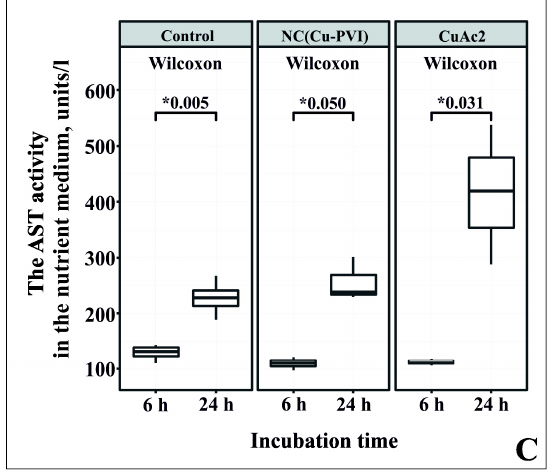
Figure 7. Change in AST activity in the culture medium after 6 h ( A ) and 24 h ( B ) of incubation with NC(Cu-PVI) or CuAc 2 compared with the control group and depending on the duration of incubation ( C ). Medians and first and third quartiles are shown. * Differences are considered significant at p < 0.05.